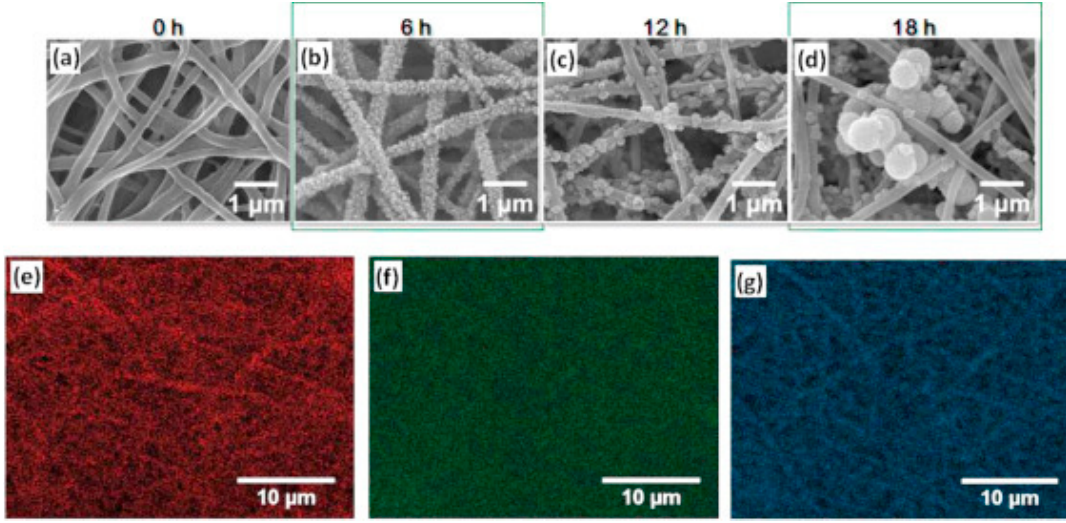
Figure 6 . SEM images of hydroxyapatite coated sodium carboxymethylcellulose nanofibers mineralized for 0 h ( a ), 6 h ( b ), 12 h ( c ), 18 h ( d ), and elemental mapping images of the NaCMC/HA nanofibers mineralized for 6 h: carbon map ( e ), calcium map ( f ), and phosphorus map ( g ) (reproduced with permission from Ref. [86]).